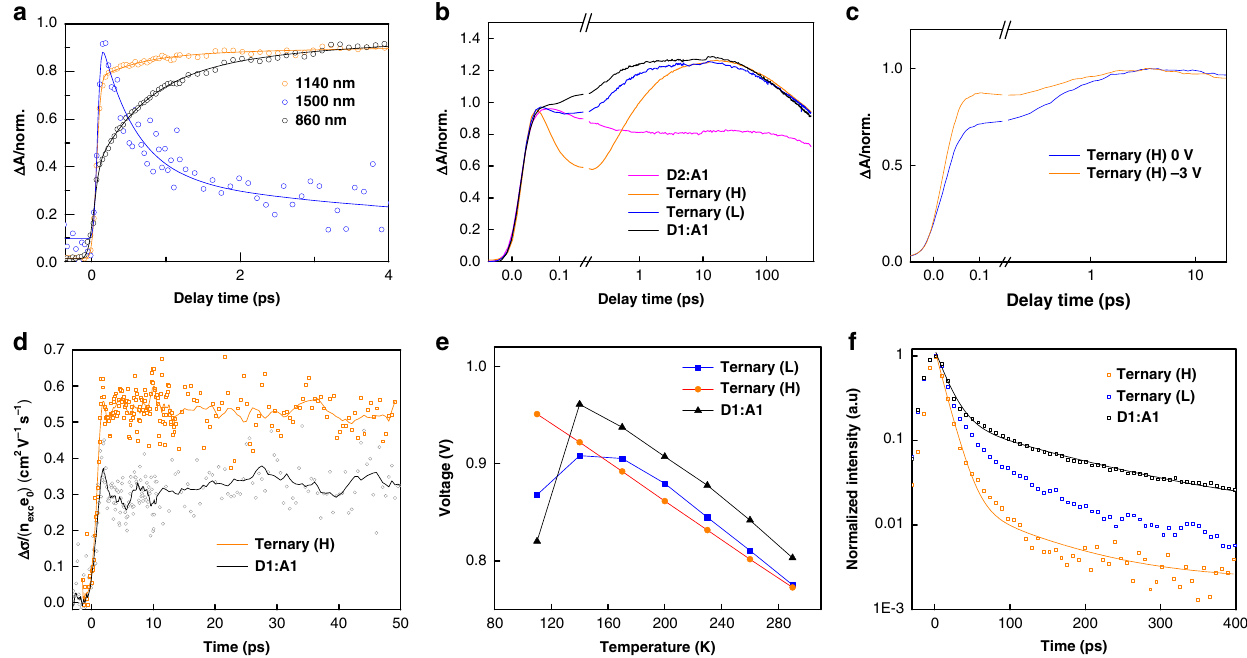
Fig. 2 Excited-state dynamics of blends. a Kinetics of Ternary(H), pumped at 700 nm, probed at 860 nm, 1142 nm and 1500 nm, respectively. b Kinetics of two ternary blends and two reference binary blends, normalized to the simultaneously acquired signal, pumped at 550 nm and probed at 860 nm. c Transient absorption spectra under negative bias of Ternary (H) device, pump at 700 nm and probe at 860 nm. d Transient THz photoconductivity kinetics ( λ exc = 400 nm, I exc = 4.5 × 10 12 ph/cm 2 ). e Temperature dependent photovoltage evolution for three blend diodes. f Kinetic curves derived from the time- resolved photoluminescence data by integrating over the spectral range 740 – 950 nm, pump at 700